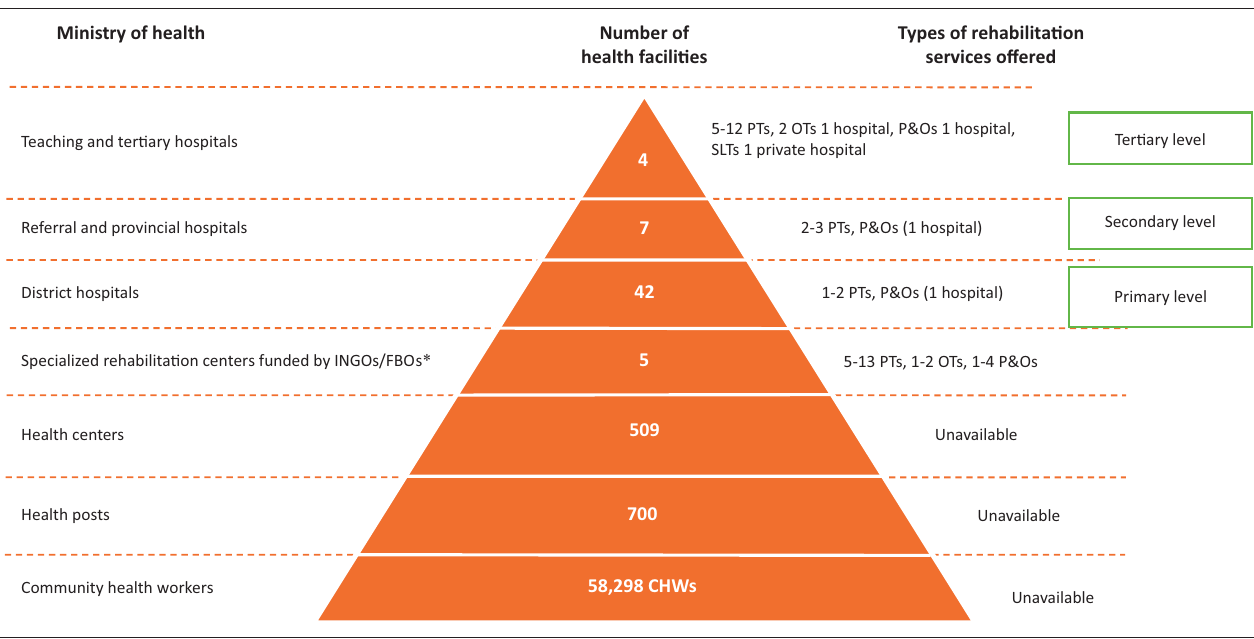
FIGURE 1-A1: Rehabilitation Sector in the Health System. Adapted from the Organization chart of the health system in